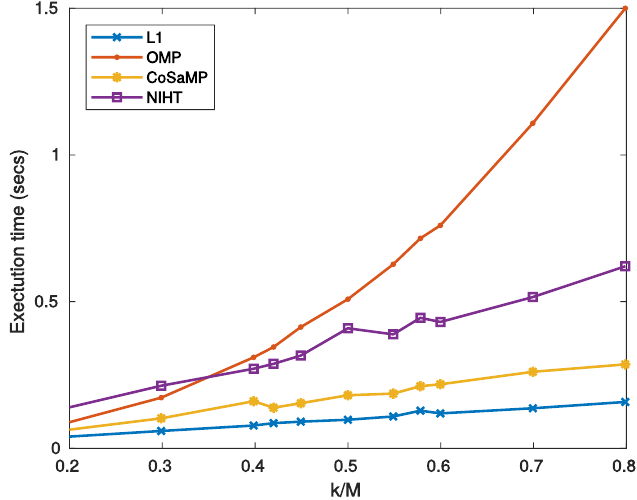
Figure 10. Case Study B—Execution time on MATLAB as a function of sparsity S M = k / M